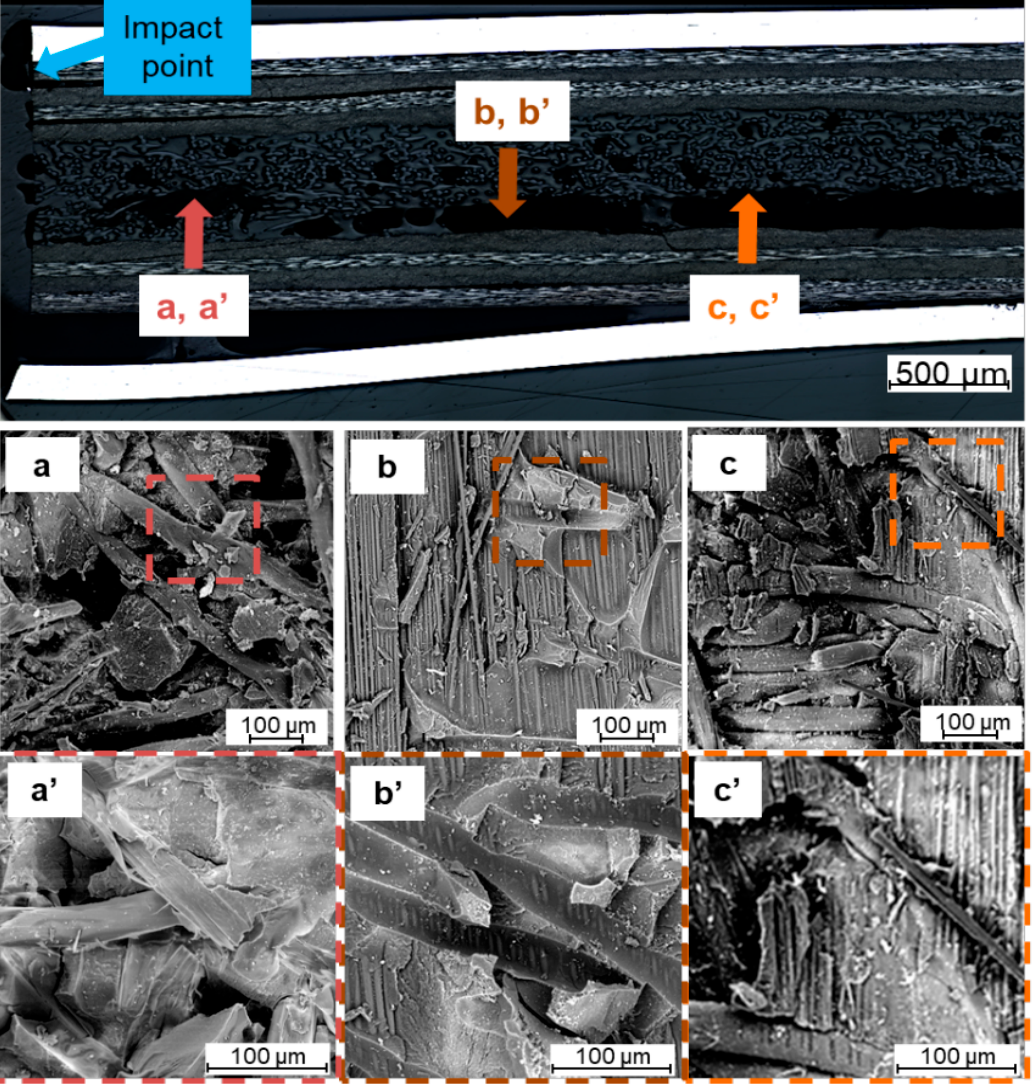
Figure 13. Morphology of the failure of foam ( a , a’ ) and foam–composite interfaces (composite surface ( b , b’ ) and foam surface ( c , c’ )) in Fibre Foam Metal Laminates after impact.